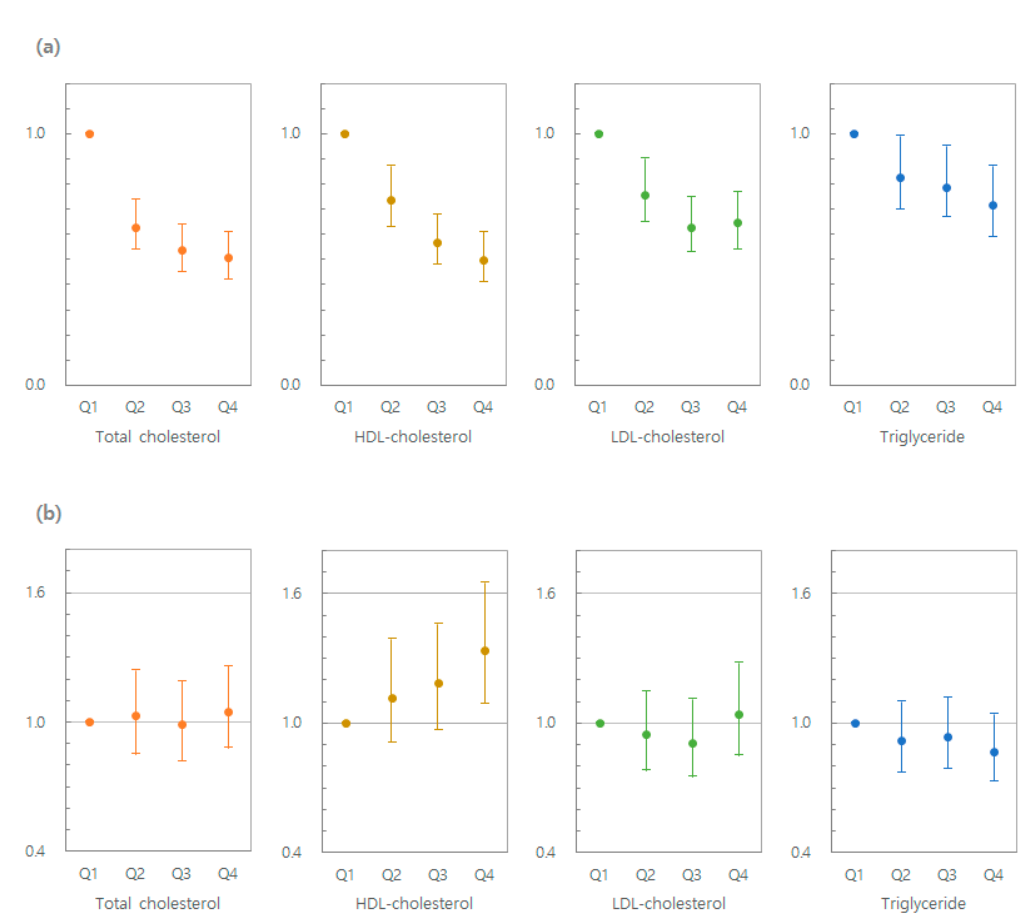
Figure 1. ( a ) Risk of multiple myeloma by quartile for lipid levels at baseline (Model 3) adjusted for age, sex, body mass index, smoking, alcohol consumption, physical activity, diabetes, and lipid-lowering medication. ( b ) Risk of multiple myeloma by quartile for lipid variability (Model 4) adjusted for age, sex, body mass index, smoking, alcohol consumption, physical activity, diabetes, lipid-lowering medication, and baseline lipid levels (TC, HDL-C, LDL-C, TG).